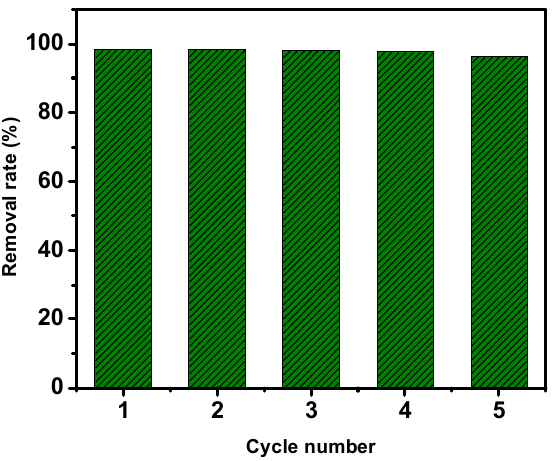
Figure 11. The removal rate of Pb 2+ during cycling. (Experimental conditions: pH = 6, MnO 2 /Mxene composite films 12 mg, solution volume 100 mL C Pb 2 + = 30 mg/L, 25 °C).